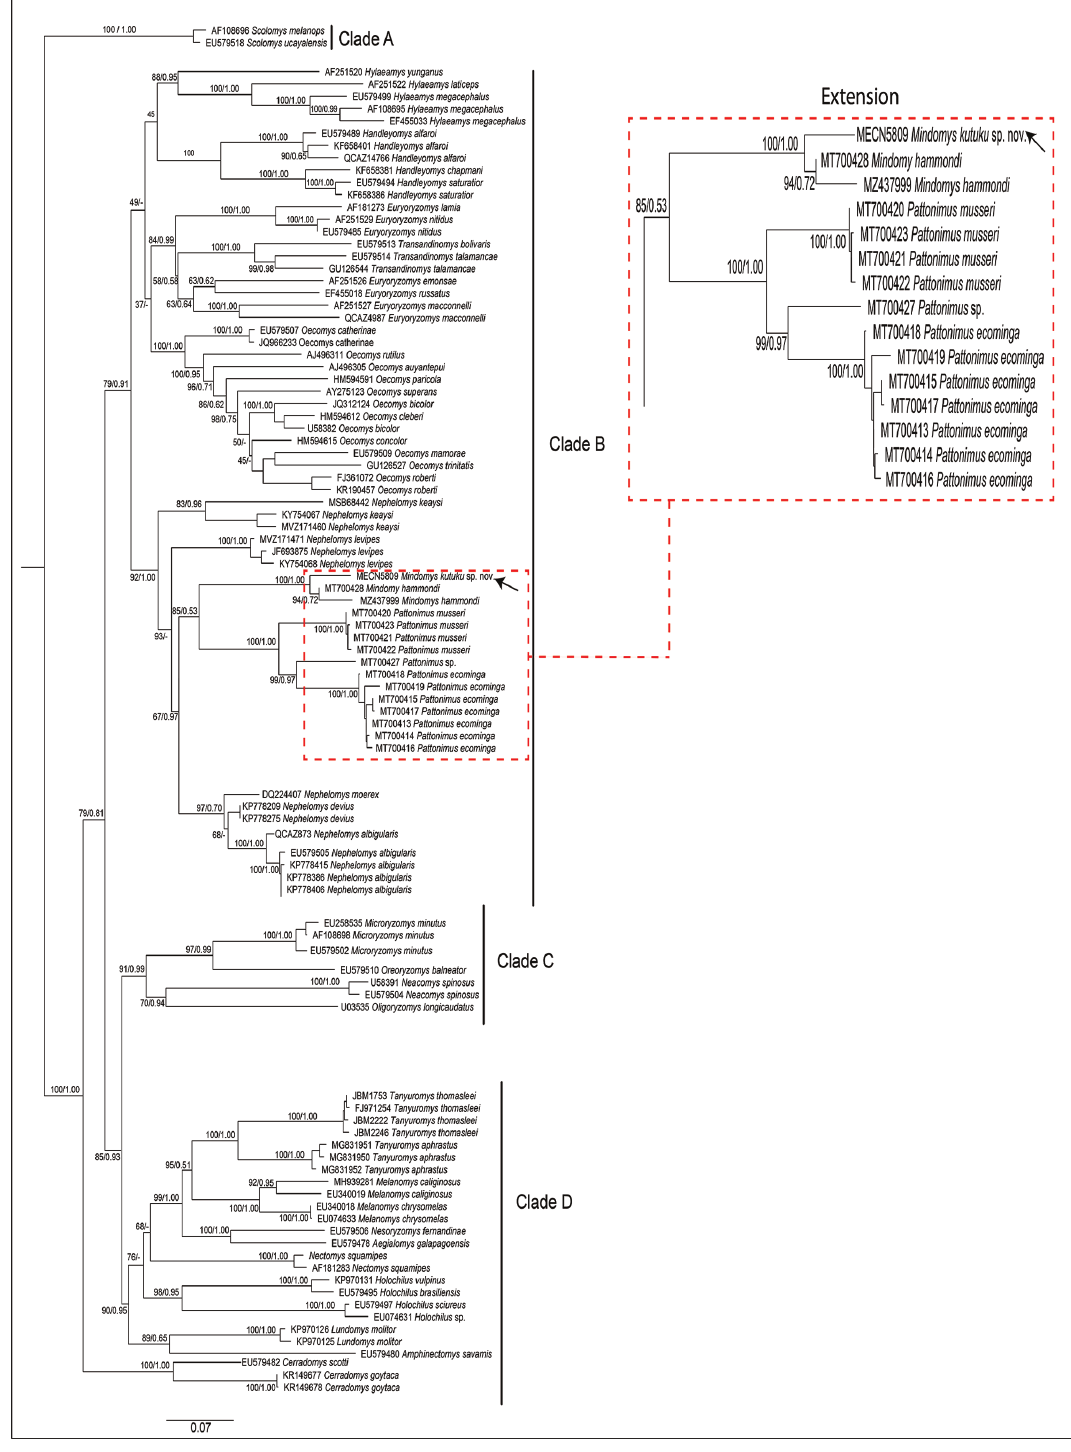
Figure 3. Phylogenetic tree of maximum likelihood of the tribe Oryzomyini based on the Cytochrome b gene. The red box high- lights the location of Mindomys and Pattonimus (magnified on the right), while the arrow indicates the new species here described as Mindomys kutuku sp. nov. Letters A–D. indicate those clades proposed by Weksler (2006). The values above and below the branches are the bootstrap values and posterior probabilities (BS / PP),